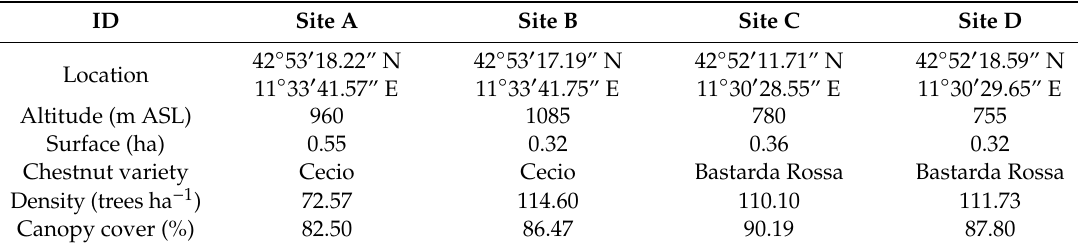
Table 1. Experimental sites’ description.